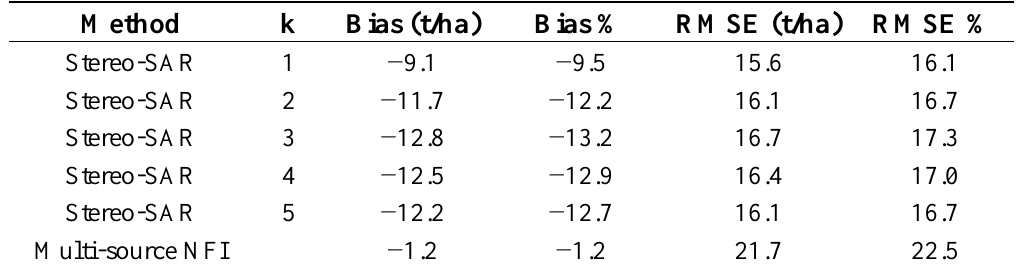
Table 6. Stand-level estimation accuracy of forest above-ground biomass (AGB) by stereo-SAR radargrammetry and multi-source NFI.